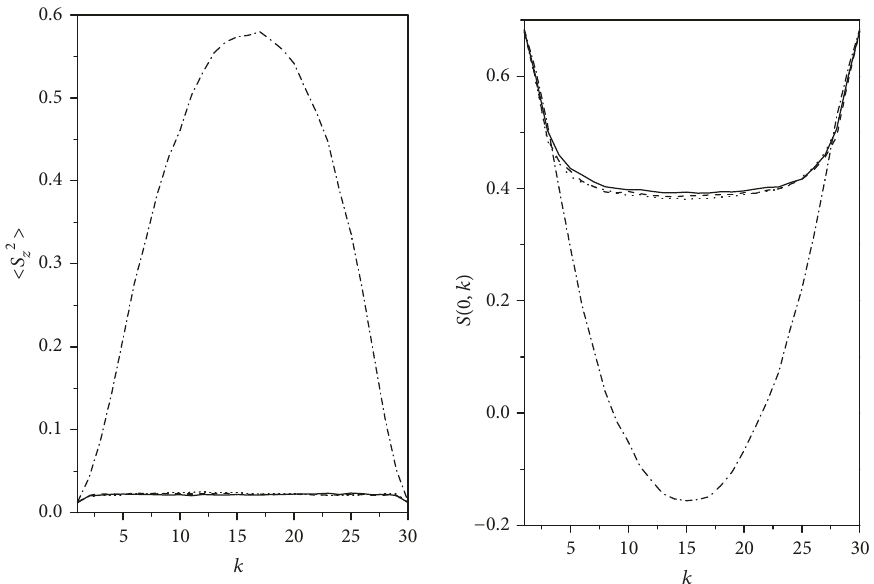
Figure 5: Dependence of the plane parameters ⟨𝑆 𝑧2 ⟩ (left) and S (0, k ) (right) on k in the case L = 30 (equilibrium spin configuration) for initial configurations “D” (solid line), “XH” (dashed line), “ZH” (dash-dotted line), and “R” (dotted line).